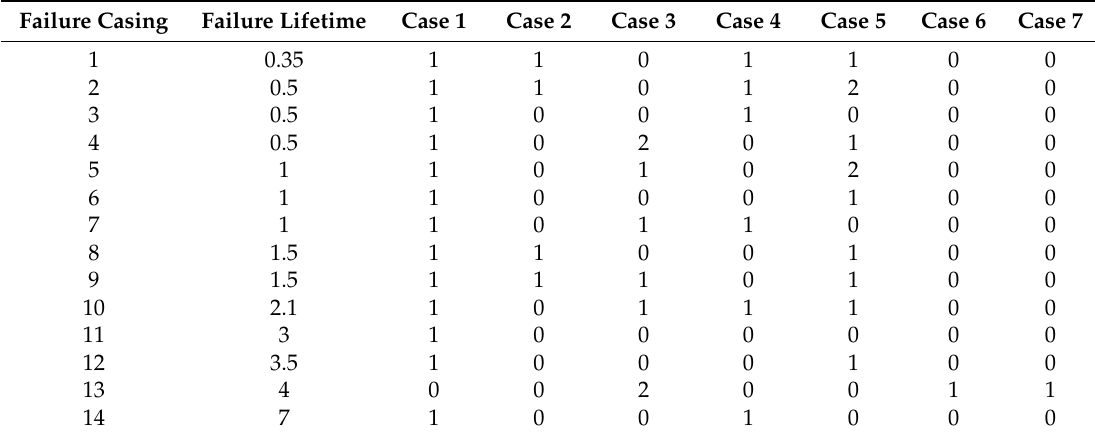
Table 2. Failure cases with failure